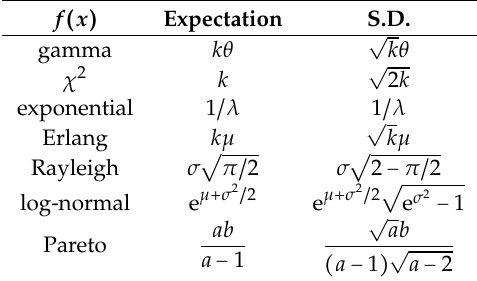
Table A1. Expected value and standard deviation of probability density distribution f ( x ) defined by x ≥